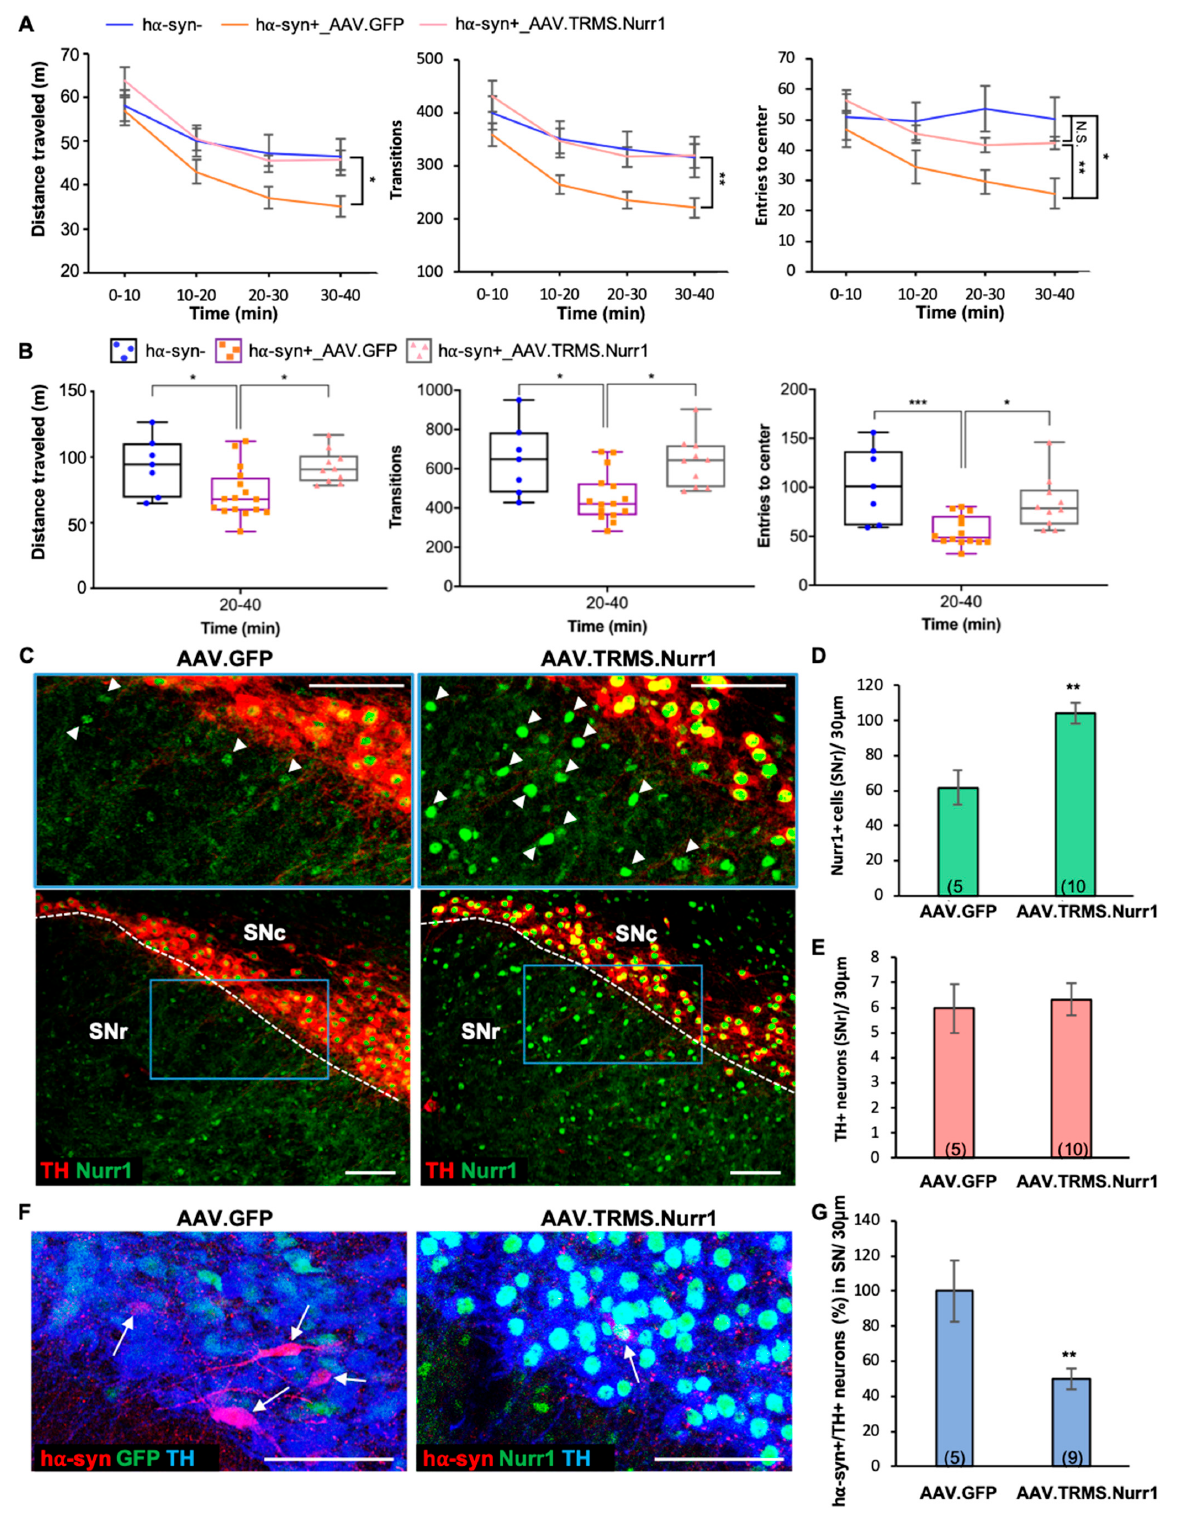
Figure 7. Nurr1 overexpression is sufficient to ameliorate PD-related locomotor deficits and decreases the number of h α -syn+ neurons in the SNc. ( A ) Locomotor activity (BPM) measured from 0 to 40 min of the testing session showed that pan-neuronal Nurr1-overexpression ameliorated PD-related locomotor deficits exhibited by h α -syn+_AAV.GFP mice (mixed model ANOVA for distance